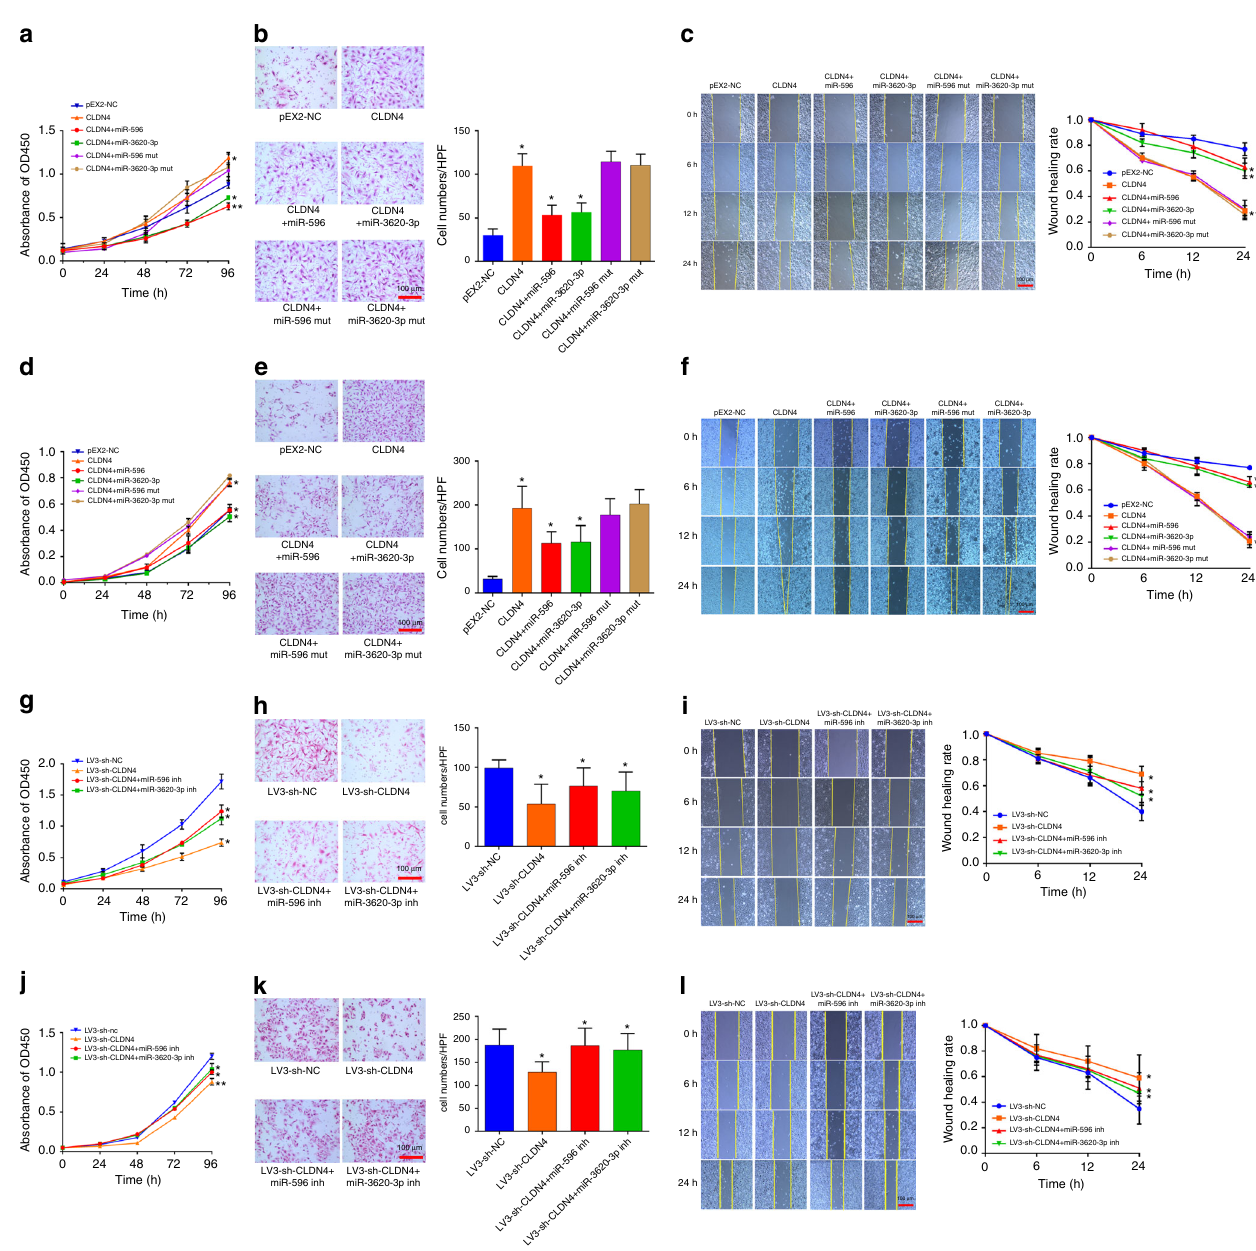
Fig. 2 CLDN4 reinforces the proliferative and invasive capacity of GC cells in vitro. a Cell proliferation was assessed daily for 4 days using the Cell Counting Kit-8 (CCK-8) assay in CLDN4 overexpressing SGC-7901 cells. b Transwell assays were used to evaluate the involvement of CLDN4 for invasion in CLDN4 overexpressing SGC-7901 cells. c Scrape motility assays were monitored at 0, 6, 12, and 24 h in CLDN4 overexpressing SGC-7901 cells. d Cell proliferation assessed in CLDN4 overexpressing AGS cells. e Transwell assays assessed in CLDN4 overexpressing AGS cells. f Scrape motility assays in CLDN4 overexpressing AGS cells. g Cell proliferation assessed in CLDN4 knockdown SGC-7901 cells. h Transwell assays assessed in CLDN4 knockdown SGC-7901 cells. i Scrape motility assays in CLDN4 knockdown SGC-7901 cells. j Cell proliferation assessed in CLDN4 knockdown AGS cells. k Transwell assays assessed in CLDN4 knockdown AGS cells. l Scrape motility assays in CLDN4 knockdown AGS cells. In b , e , h , and k , cells were incubated for 24h, and counted under the microscope. Original magni fi cation ×200. Scale bars = 100 μ m. Data are shown as mean ± s.d., n = 3. The data statistical signi fi cance is assessed by Student ’ s t -test. * P < 0.05, ** P <